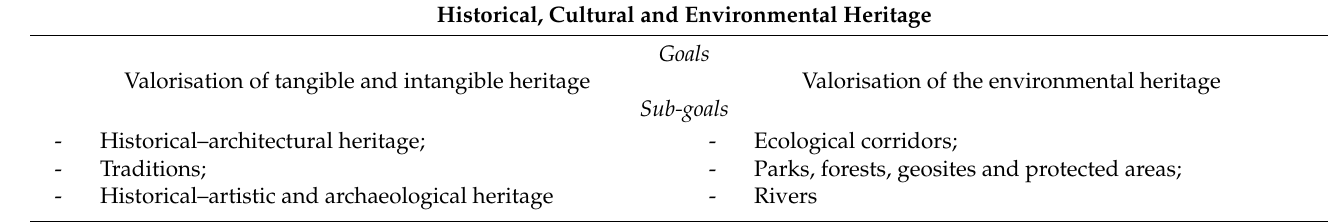
Table 6. Declination of the “Historical, cultural and environmental heritage” strategic axis into goals and